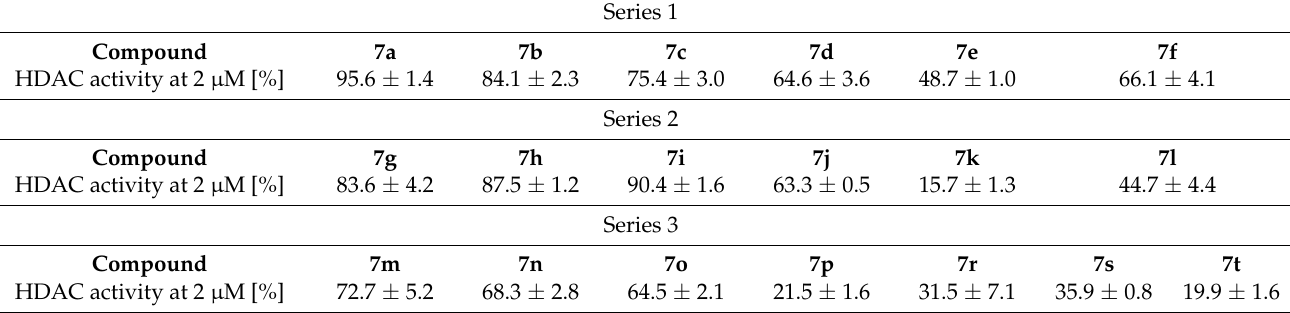
Figure 3. Structure-related activity of Vorinostat derivatives 7a – l showing the percentage of HDACs activity at 2 µM depending on the side chain length. Table 1. HDACs inhibition of newly synthesized Vorinostat derivatives 7a – l . For Vorinostat ( 1 ) HDACs activity at 2 µM was 23.8 ± 2.2.